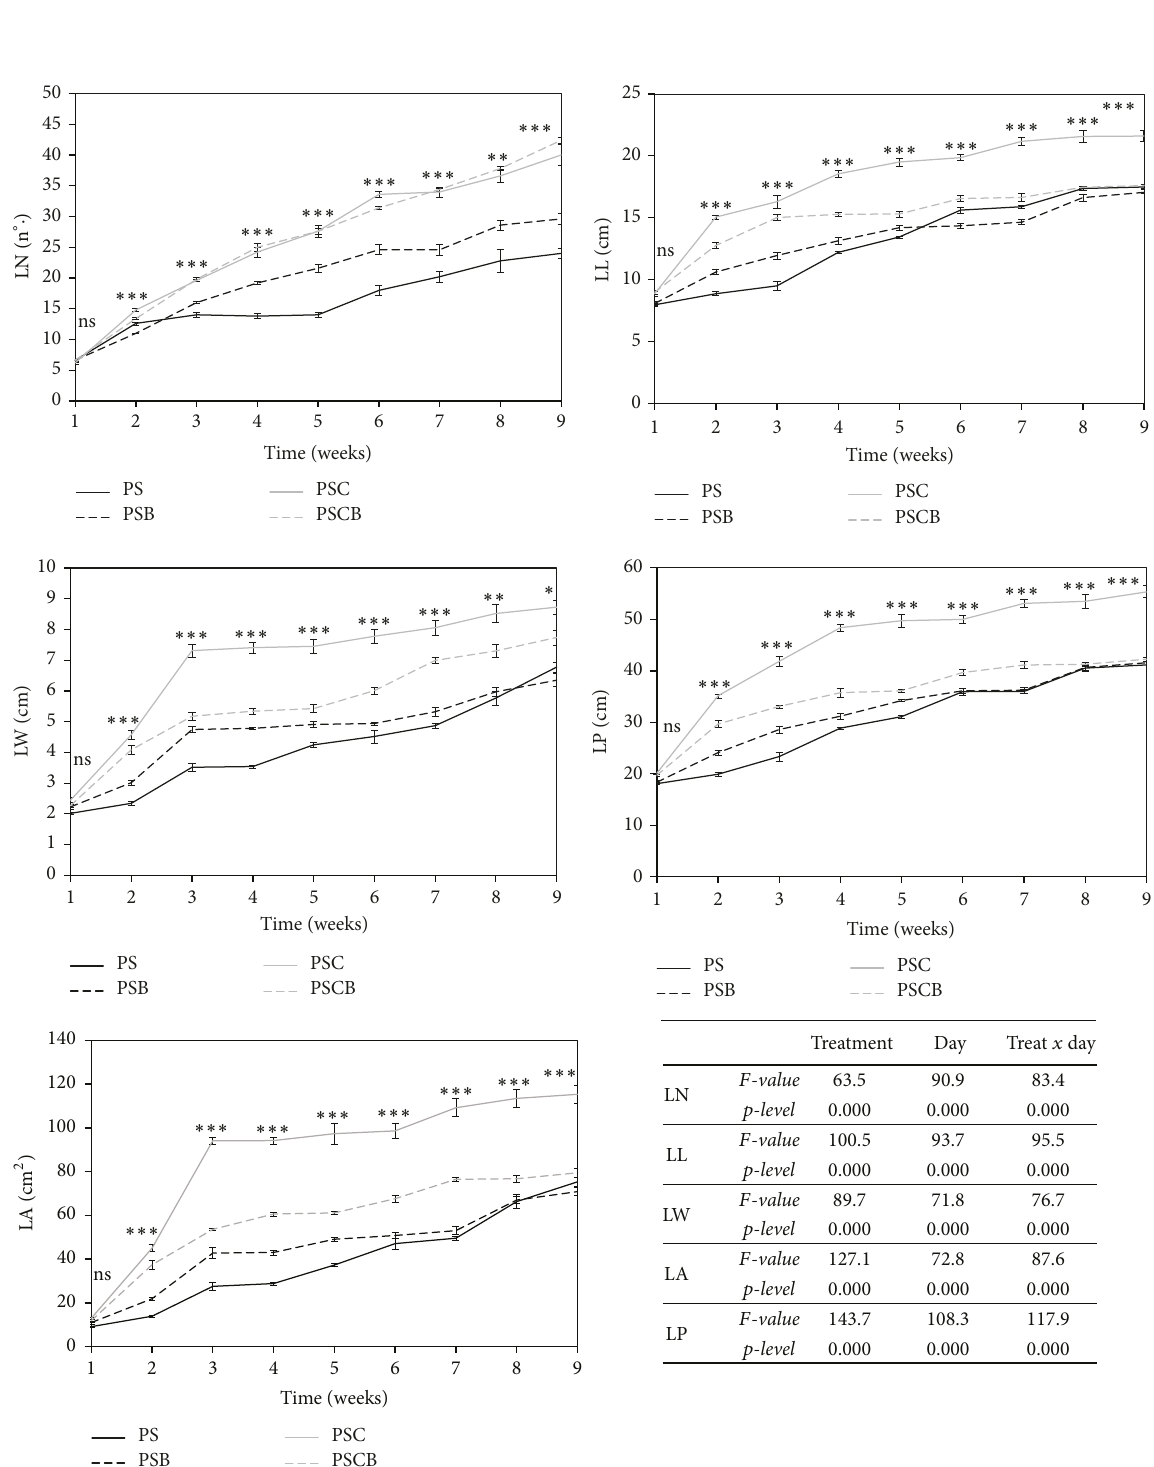
Figure 2: Morphological analysis . The main leaf parameters were analyzed: LN = leaf number; LL = leaf length; LW = leaf width; LA = leaf area; LP = leaf perimeter. Data represent the mean ( 𝑛 = 6 ) ± standard error. Mean values marked with asterisks are statistically different at ∗∗∗ 𝑝 ≤ 0.0001 , at ∗∗ 𝑝 ≤ 0.005 , and at ∗ 𝑝 ≤ 0.01 . Two-way ANOVA was applied to weigh the effects of day, treatment, and their interactions on plant growth parameters ( 𝑝 and 𝐹 level values are reported). PS = lettuce plants grown in unfertilized soil; PSB = lettuce plants grown in unfertilized soil plus biochar; PSC = lettuce plants grown in unfertilized soil plus compost; and PSCB = lettuce plants grown in unfertilized soil plus compost and